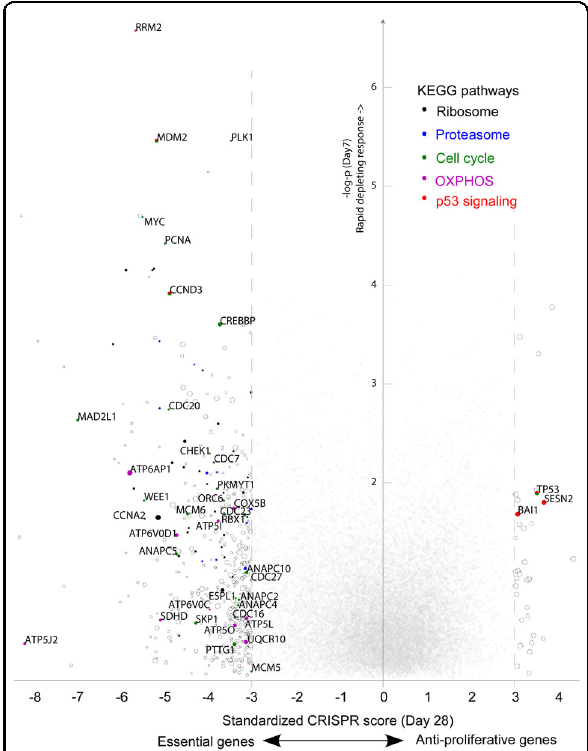
Fig. 4 Gene set enrichment analysis (GSEA) of 50 hallmark pathways. Normalized gene enrichment scores based on RC-K8 screening results (CRISPR scores) at four time points (coloured dots) compared to enrichment scores based on previously reported screens from B-cell lymphoma cell lines (grey triangles) and 341 cancer cell lines from the CERES data (box plot). Pathways are sorted by median enrichment scores of all cell lines. T-statistics were calculated by comparing the enrichment scores between lymphoma cell lines and CERES cell lines, indicating the speci fi city of enrichments towards B-cell